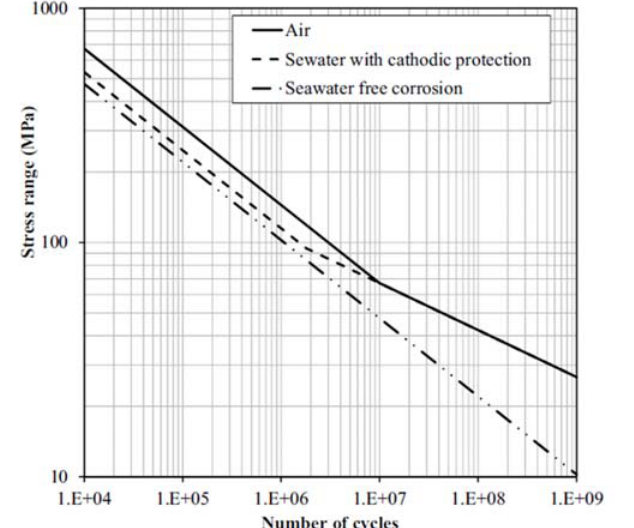
Figure 4: S-N curves for tubular joints in air environment, seawater with cathodic protection and free corrosion [4]. Simplified